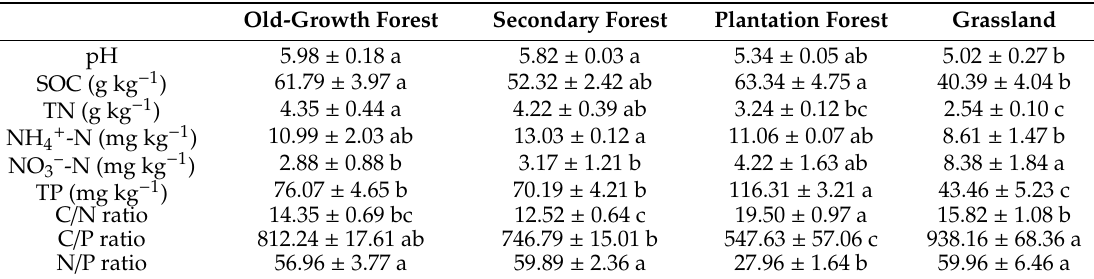
Table 1. Soil physicochemical properties of the upper 0–10 cm soil in di ff erent land-use types. Values are means ± SE. Di ff erent letters indicate statistically significant di ff erences among the land-use types (Tukey HSD test, 5%